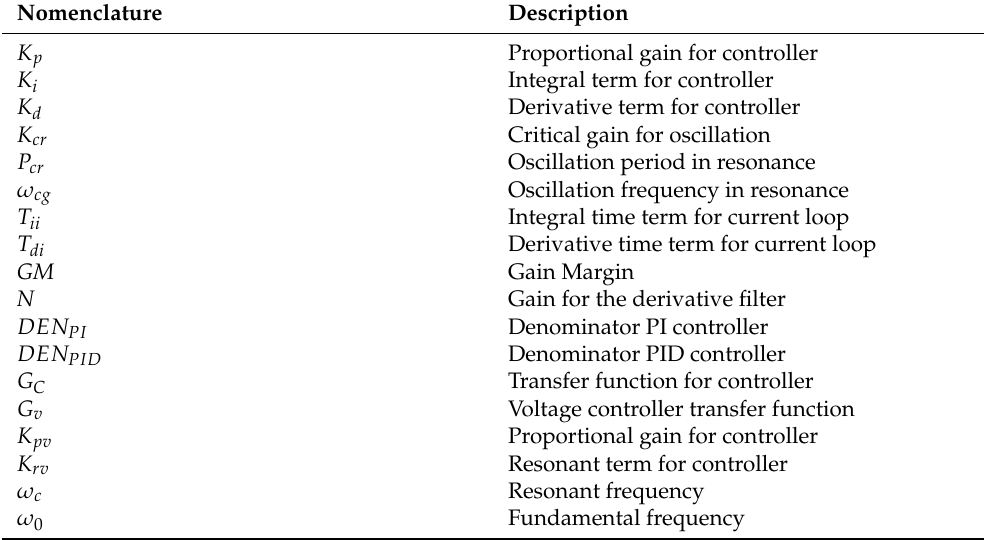
Table 1. Parameters and variables for primary